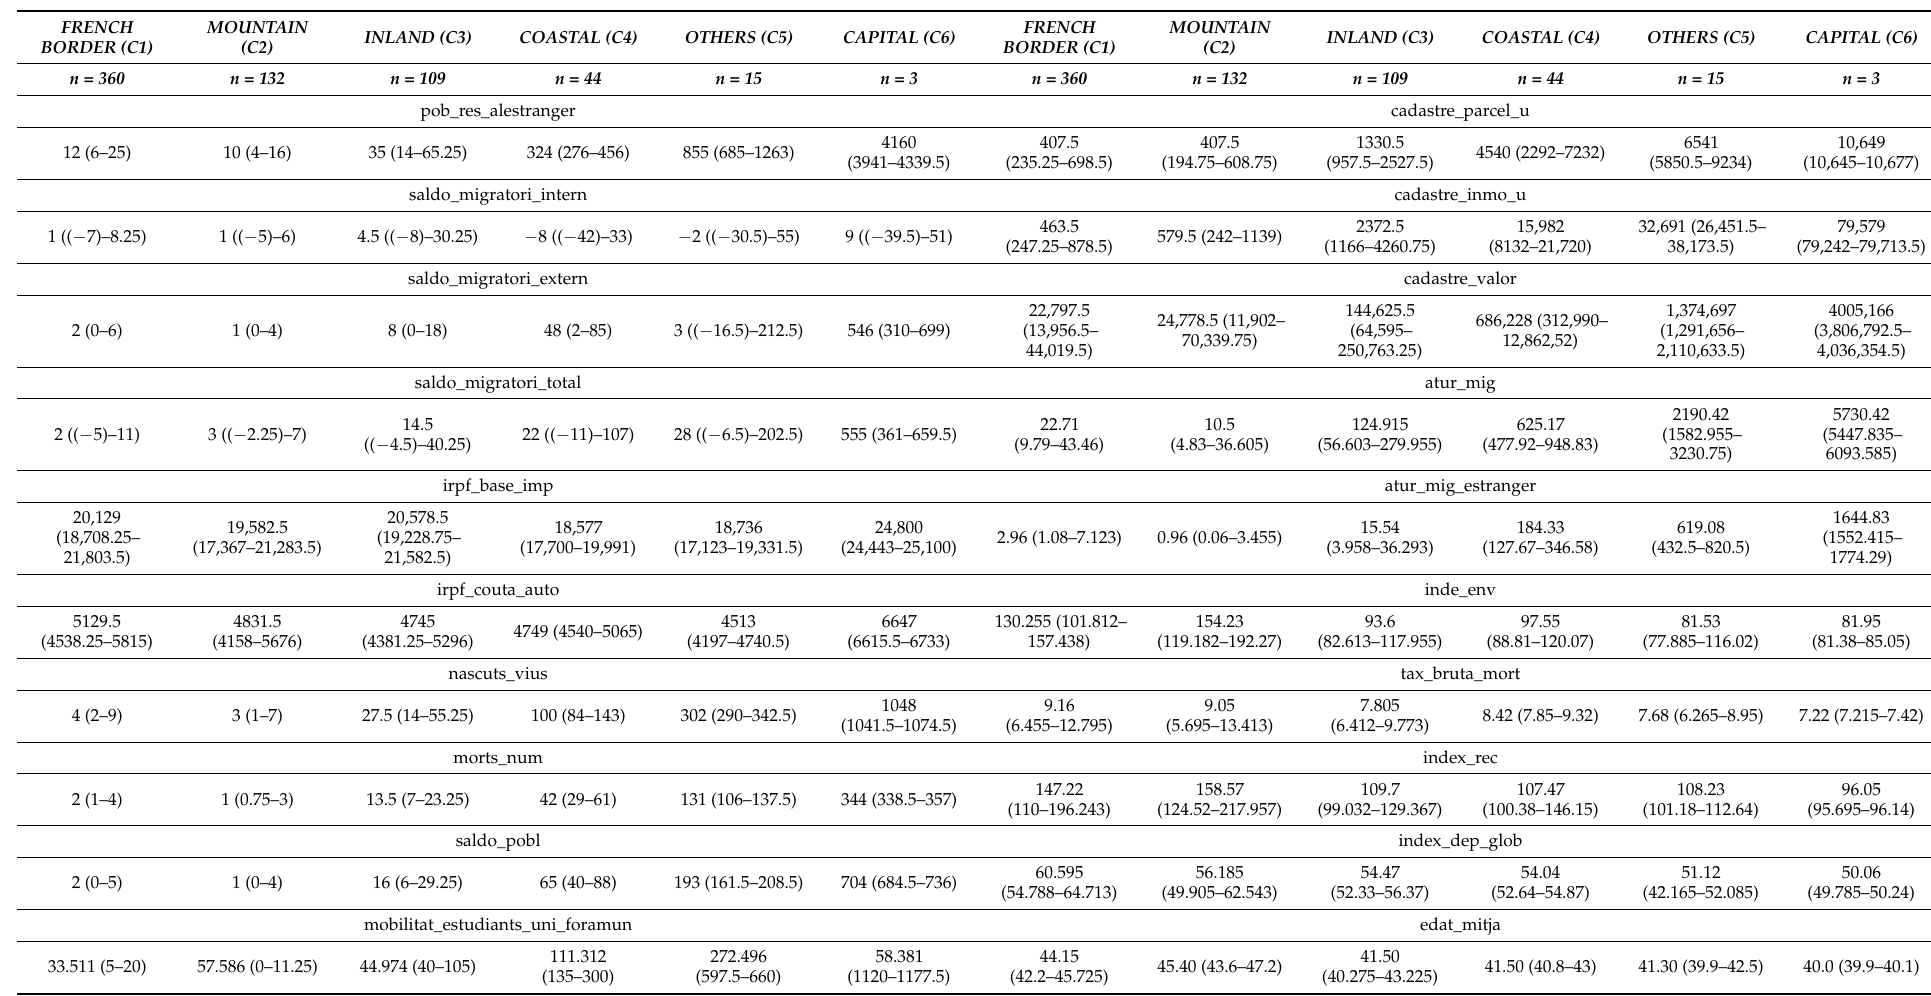
Table 5. Descriptive analysis by conglomerates, only robust values (median (1st quartile–3rd